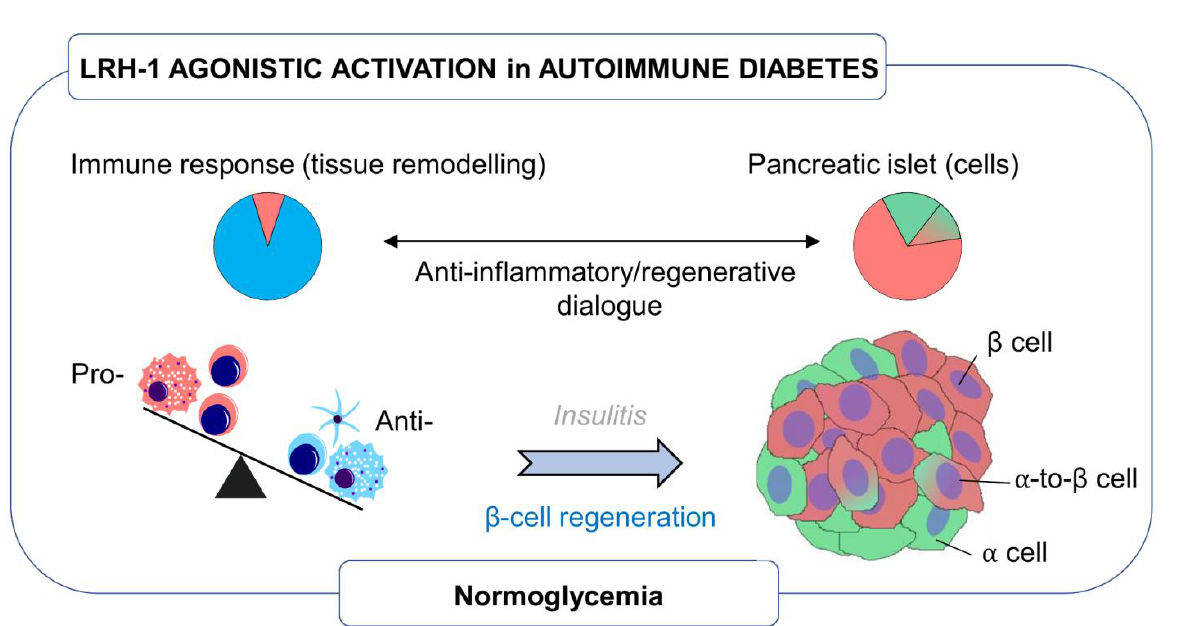
FIGURE 1: Schematic overview of LRH-1 agonistic activation in favouring and anti-inflammatory and pro-islet regenerative environment implicating alpha-to-beta cell transdifferentiation. Pie charts depict the relative percentage of either immune or islet cells under the vari- ous